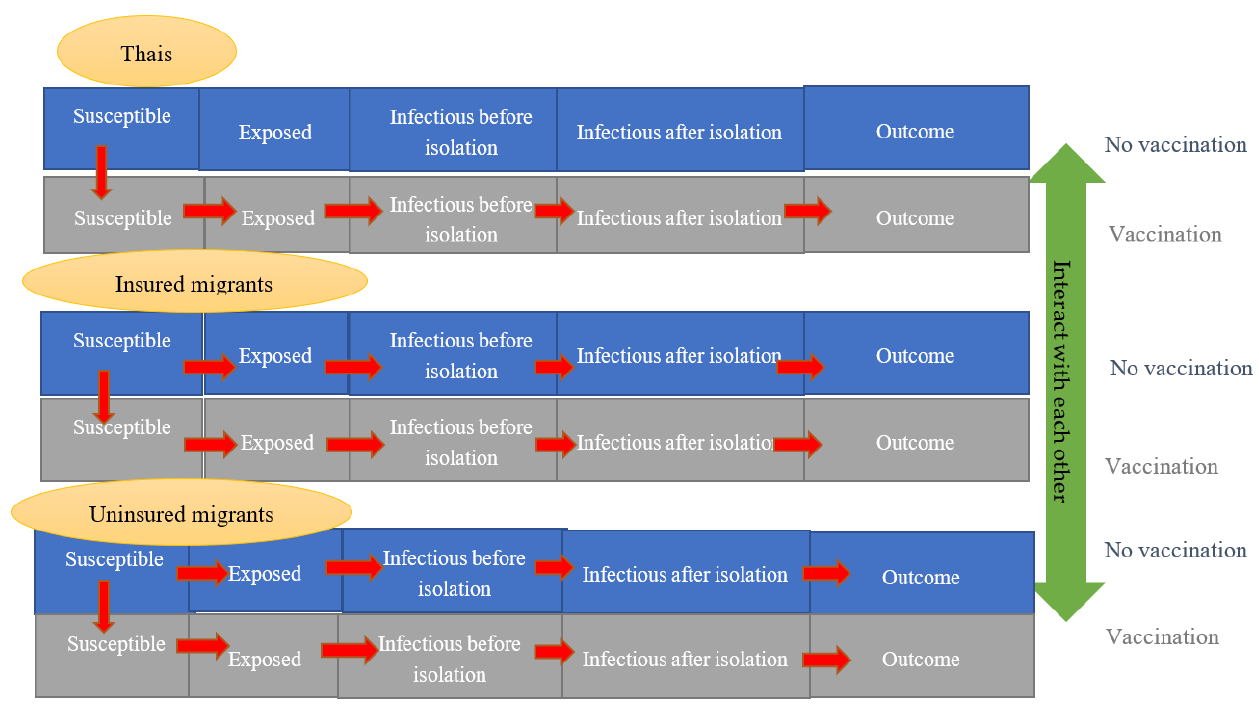
Figure 1. Model Figure 1. Model framework.